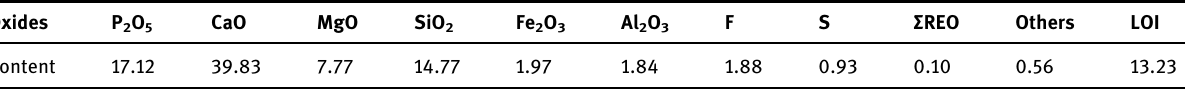
Table 1: Chemical analysis of Zhijin phosphate ore ( wt% )